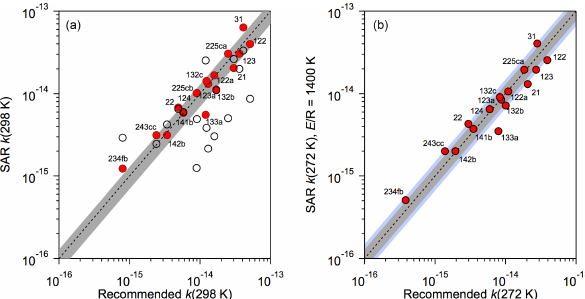
Figure 1. Comparison of structure activity relationship (SAR) OH rate coefficients for the training dataset (Table 1) with rate coeffi- cients recommended in Burkholder et al. (2015). (a) Rate coeffi- cients at 298K using the SAR of DeMore (1996) (solid symbols) and Kwok and Atkinson (1995) (open symbols). The dashed line is the 1 : 1 correlation and the shaded region is the ± 30% spread around the 1 : 1 line. (b) Rate coefficients at 272K using the SAR of DeMore (1996) (solid symbols) with an E/R = 1400K. The dashed line is the 1 : 1 correlation, the gray shaded region is the ± 30% spread, and the blue shaded region is the ± 50% spread around the 1 : 1